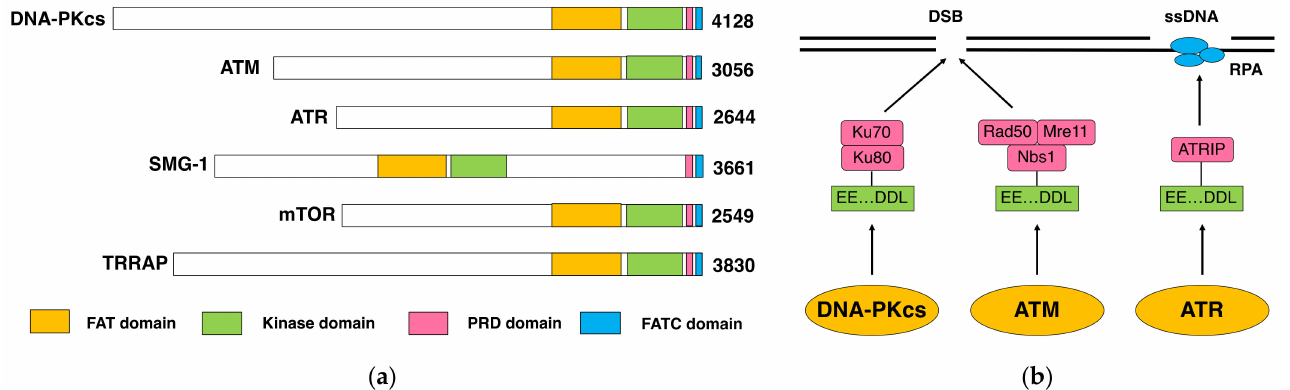
Figure 1. The similarity of DNA-PKcs to ATM and other PIKKs. ( a ) The architecture of DNA-PKcs, ATM and other PIKKs. FAT: FRAP-ATM-TRRAP, PRD: PIKK-regulatory and FATC: FAT C-terminal. ( b ) The mechanisms of the recruitment of DNA-PKcs, ATM and ATR to DSB and